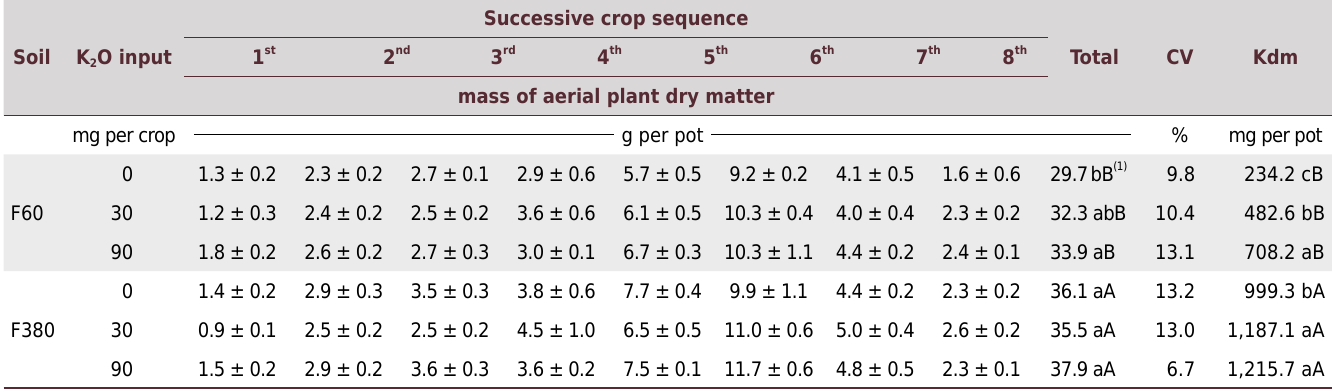
Table 3. Aerial plant dry matter and total K accumulated in the plant dry mass (Kdm) under greenhouse conditions in a Ferralsol from Paraná, Brazil